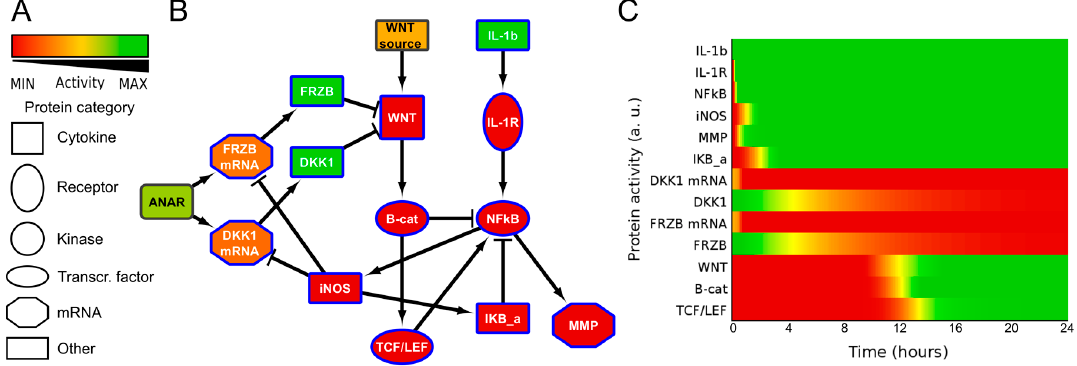
Figure 2. Network diagram (( B ), model 1) and corresponding activity heatmap ( C ) of the interleukin 1 β and Wingless-Type MMTV Integration Site Family (WNT) signaling pathway, in which nitric oxide synthase (iNOS) inhibits DKK1 and FRZB expression, resulting in WNT activity. ( A ) Activities are color coded from red = inactive, via yellow to green = fully active. The shape of the nodes indicate the type of protein or gene/mRNA; ( B ) Simplified network. Il-1b= IL1 β , IKB-a = I κ B α . For simplicity, the self-inactivating edges that formalize mRNA/protein activity life-time are not shown. The complete model, including self-inactivating edges can be found in the supplemental Figure S5A,B (interaction parameters are in Table S2, initial activities of all models are shown in Table S3).The colors of the nodes indicate their initial activity, and these colors correspond to the activity heatmap in ( C ); ( C ) activity heatmap of the network in ( B ).